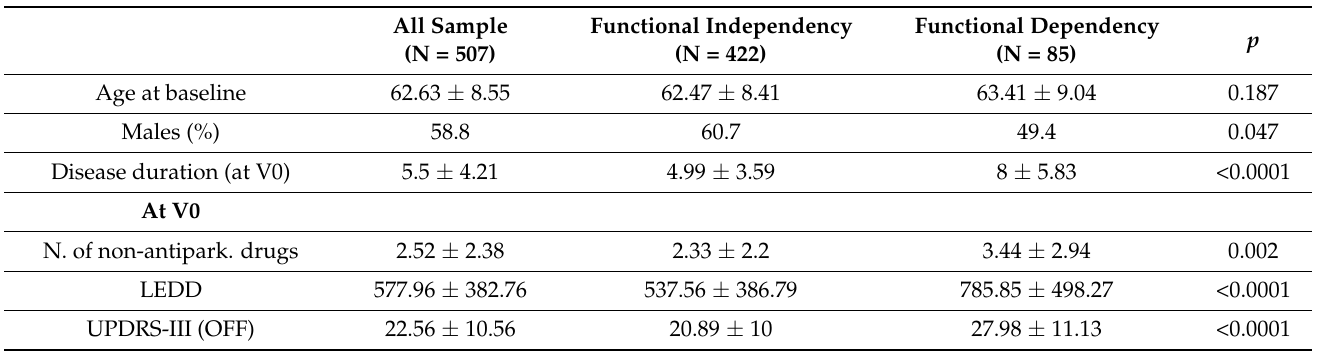
Table 2. Different PD related variables in PD patients at V2 (2 years ± 1 month) with functional dependency (N = 85) vs. those ones with functional independency (N =